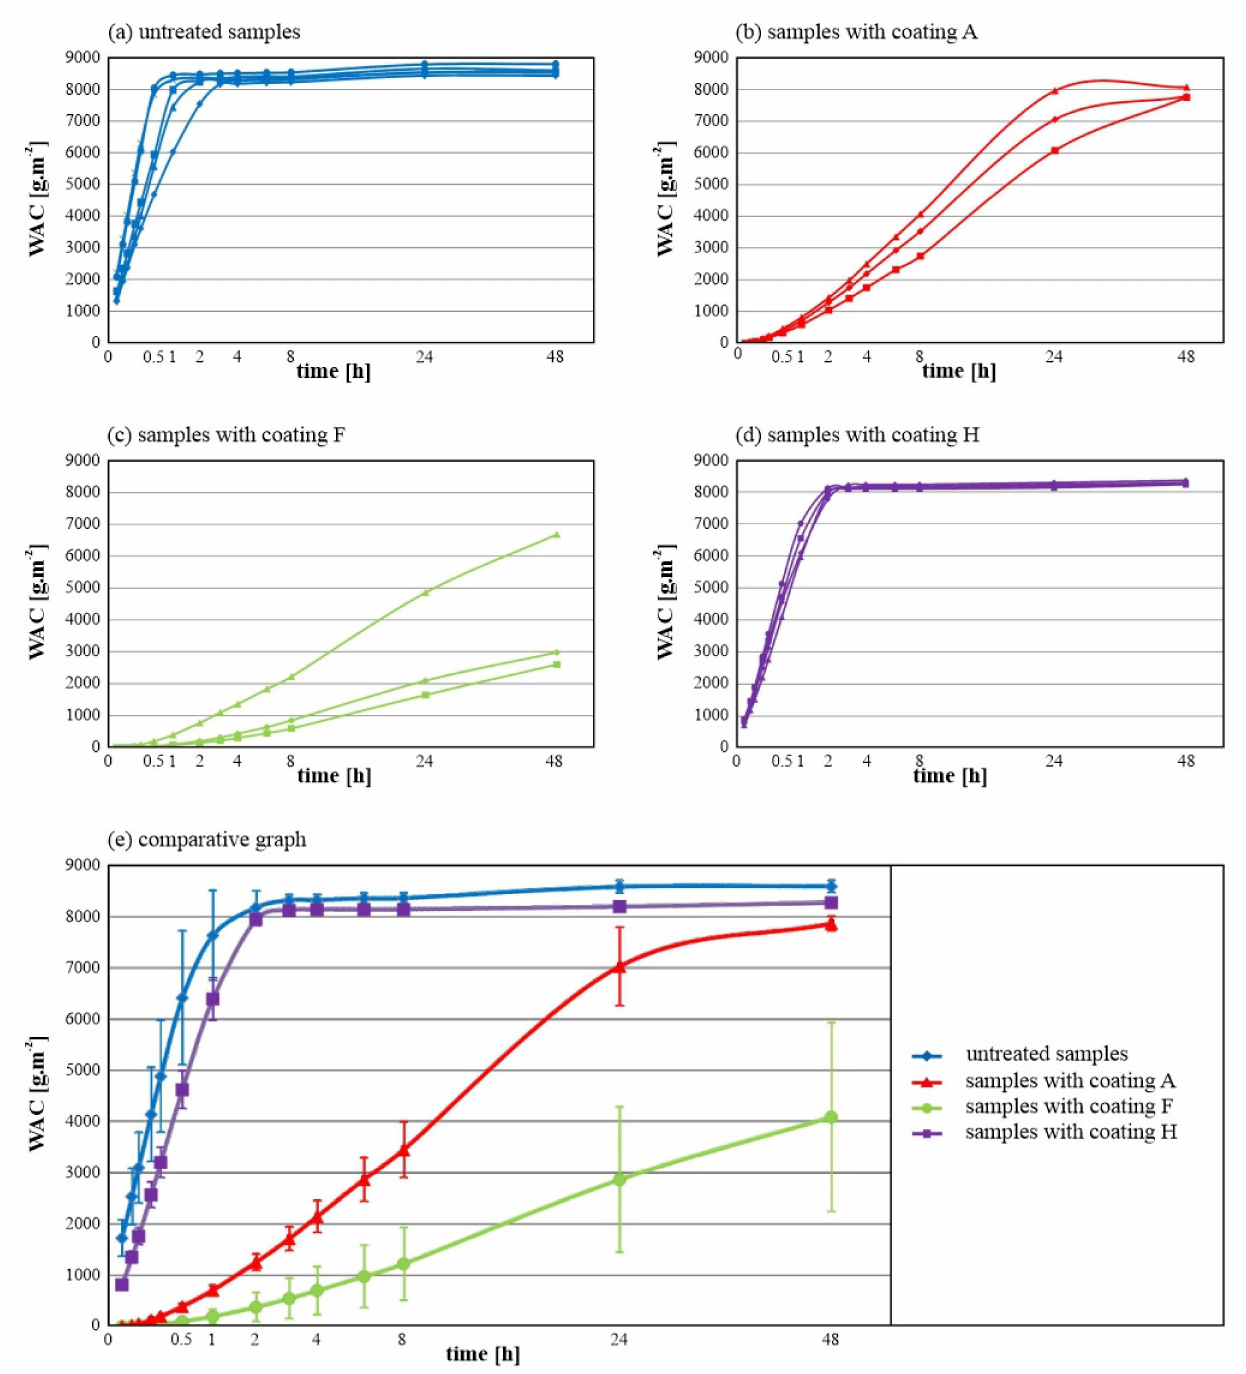
Figure 3. Curves of water absorption by capillarity—HS, ( a ) is for untreated samples, ( b ) is for samples with coating A, ( c ) is for samples with coating F, ( d ) is for samples with coating H and ( e ) is comparative